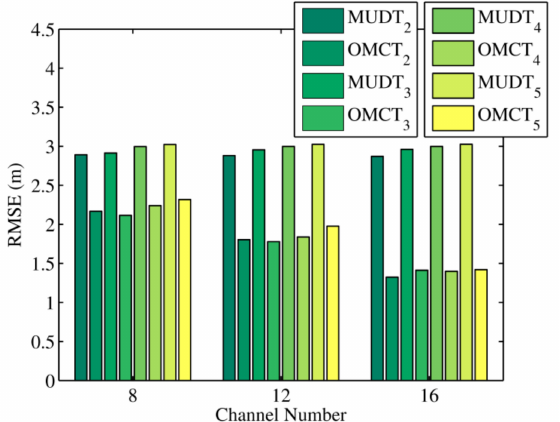
Figure 4. The RMSEs of MUDT and OMCT under di ff erent channel numbers in the